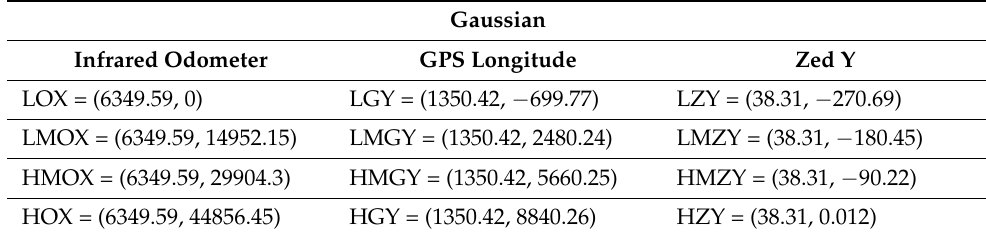
Table 4. Gaussian membership functions’ parameters.